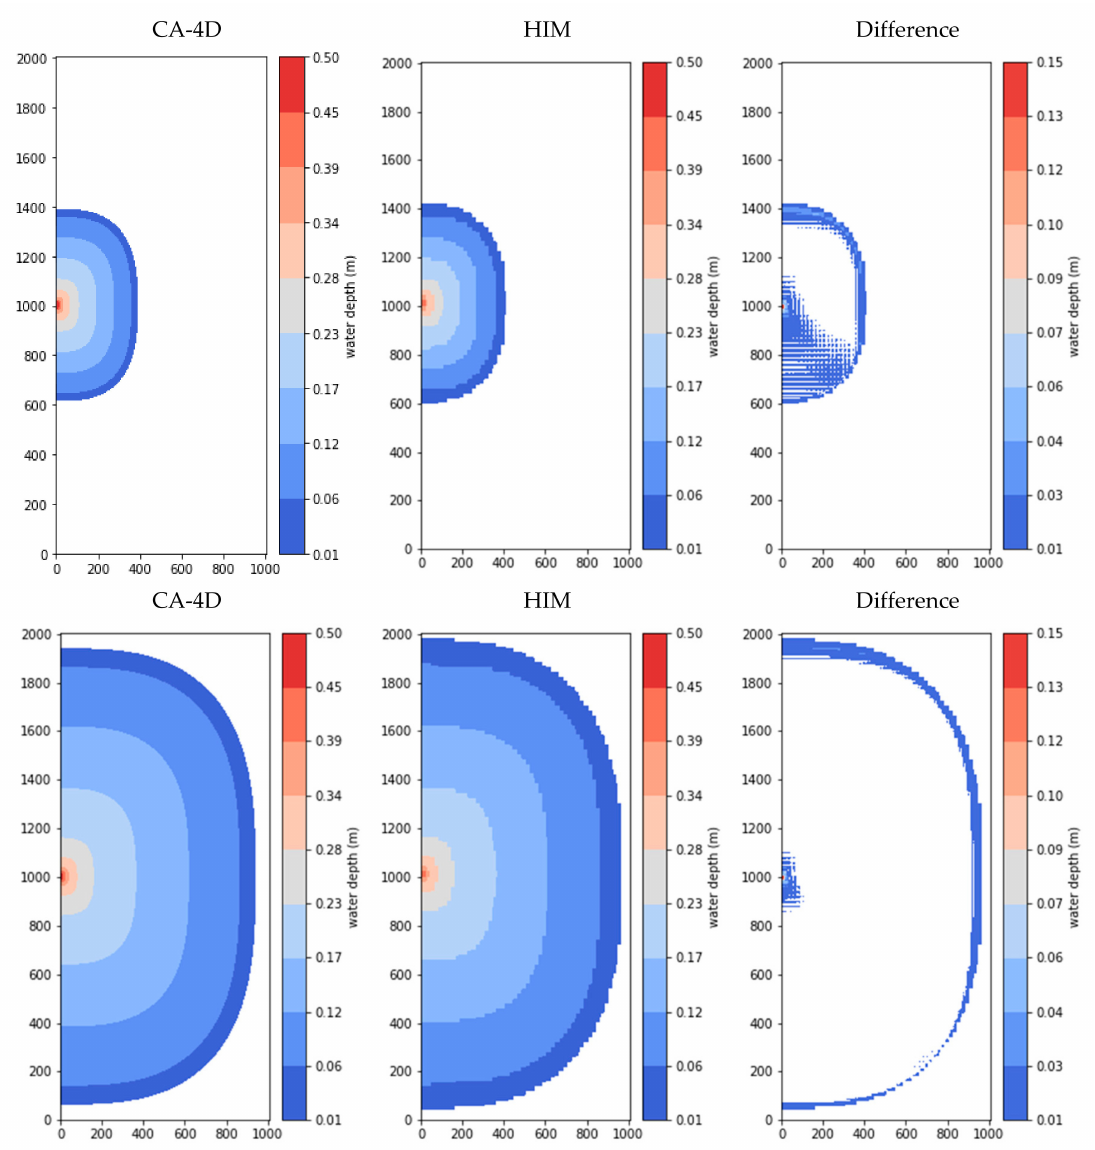
Figure 10. EAT4: comparison of flood extents at t = 1 h ( first row ) and at t = 3 h ( second row ).